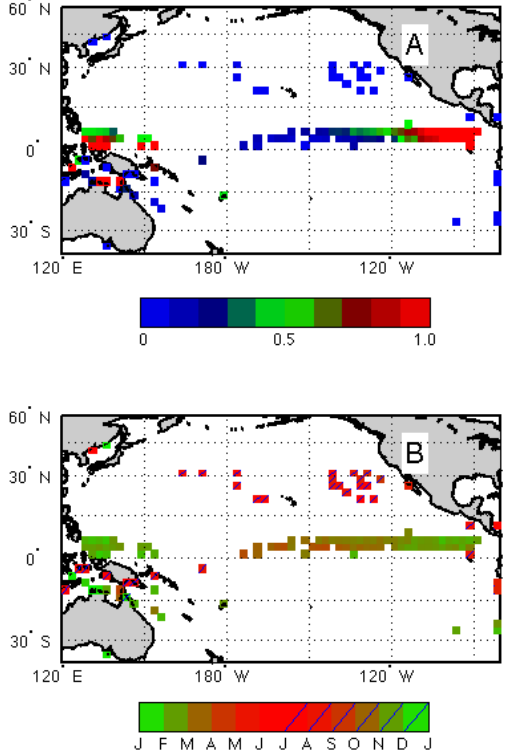
Fig. 11. Seasonal amplitude (a) and phase (b) of the entrainment term, w 0 ∂S . White or blank areas indicate that enough data ex- ∂z isted, but no significant seasonal cycle was found. Color scale for panel (a) is shown with units of 10 − 7 pss. Color scale for panel (b) is shown. Units are months indicating maximum value of w 0 ∂S